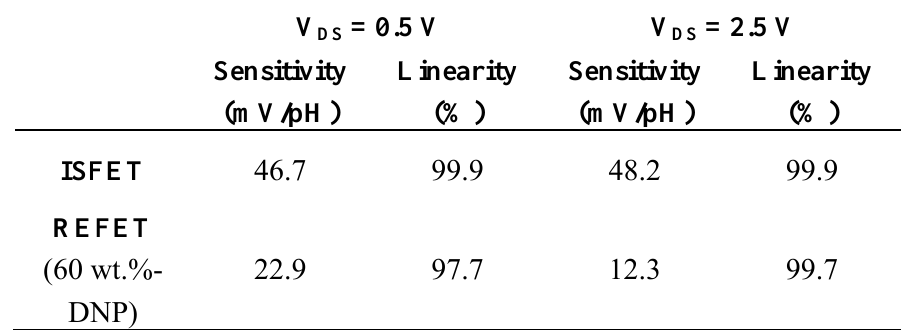
Table 3. The pH sensitivity and linearity of ISFETs and REFETs measured by a HP 4156C at 0.5 V and 2.5 with V DS